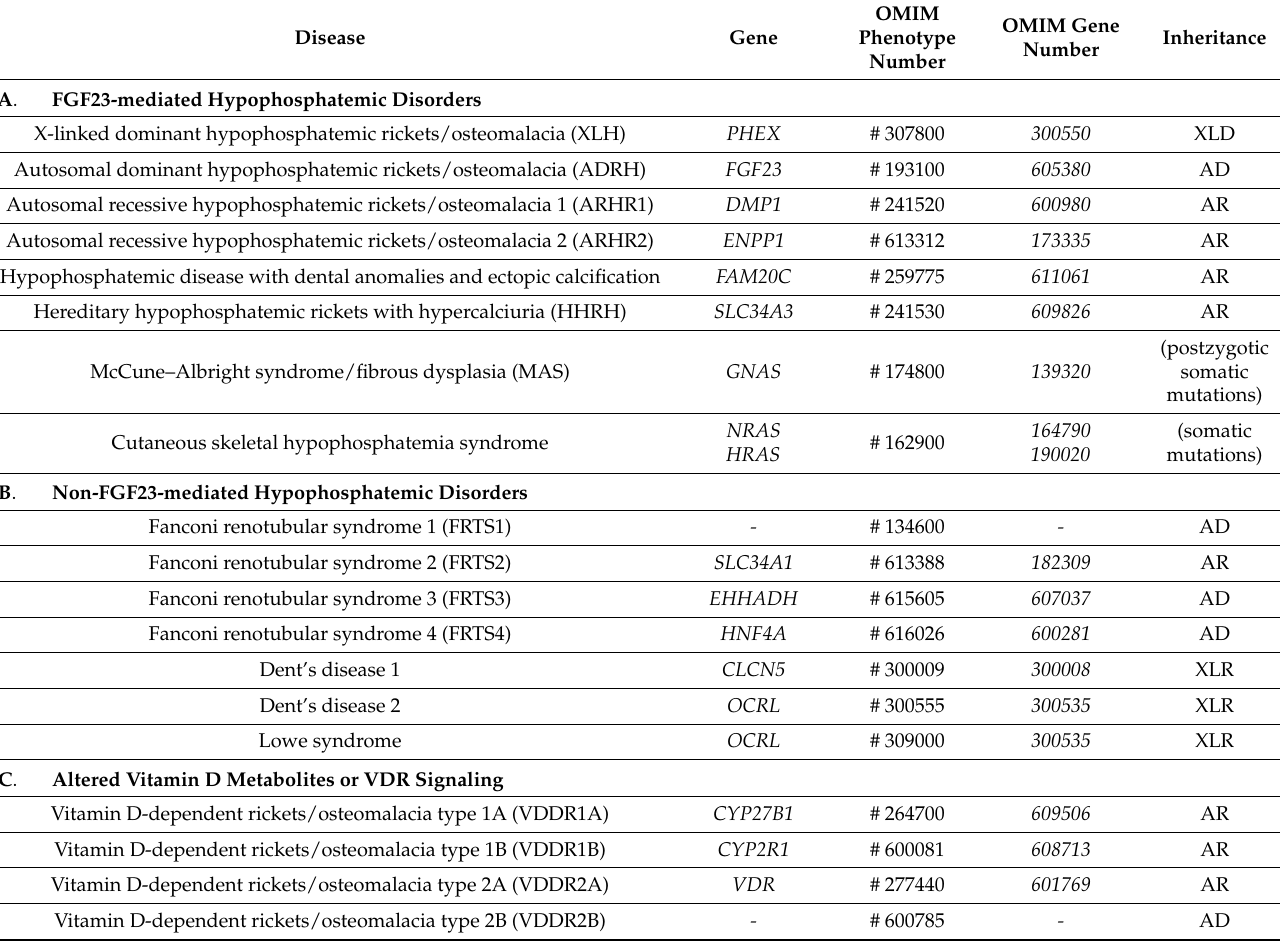
Table 3. Genetically determined forms of osteomalacia due to (A) FGF23-mediated hypophos- phatemic disorders; (B) non-FGF23 mediated hypophosphatemic disorders; (C) altered vitamin D metabolites or